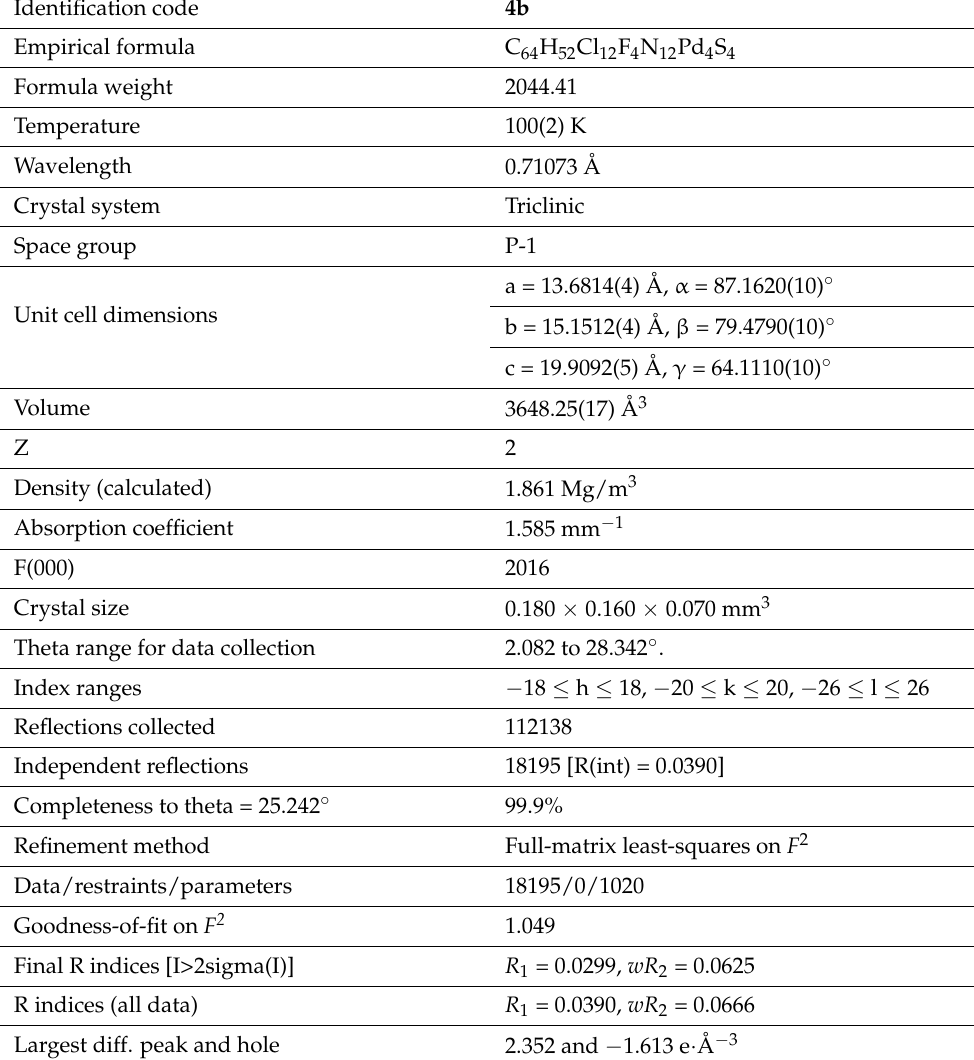
Table A2. Crystal data and structure refinement for 4b